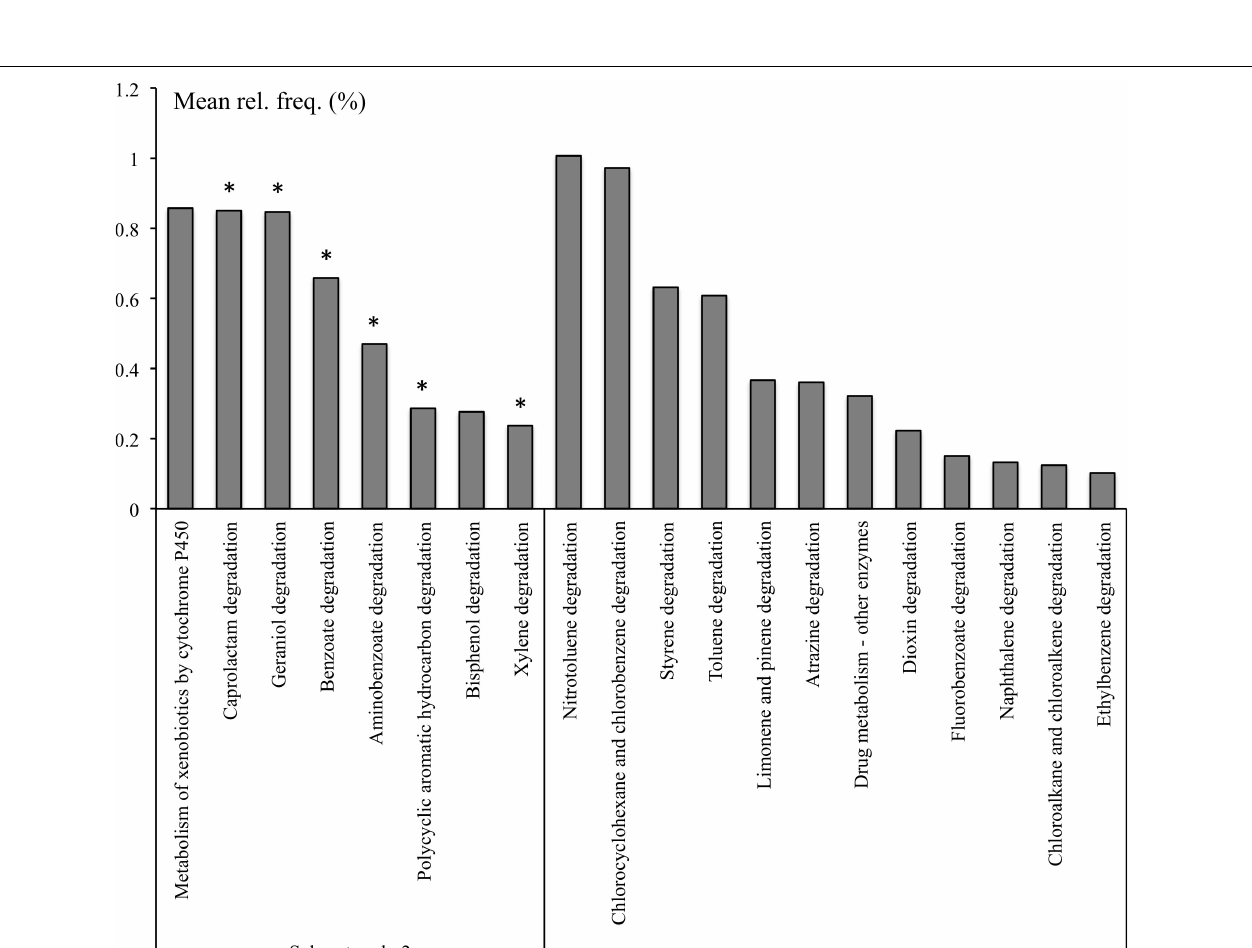
Frontiers in Microbiology |